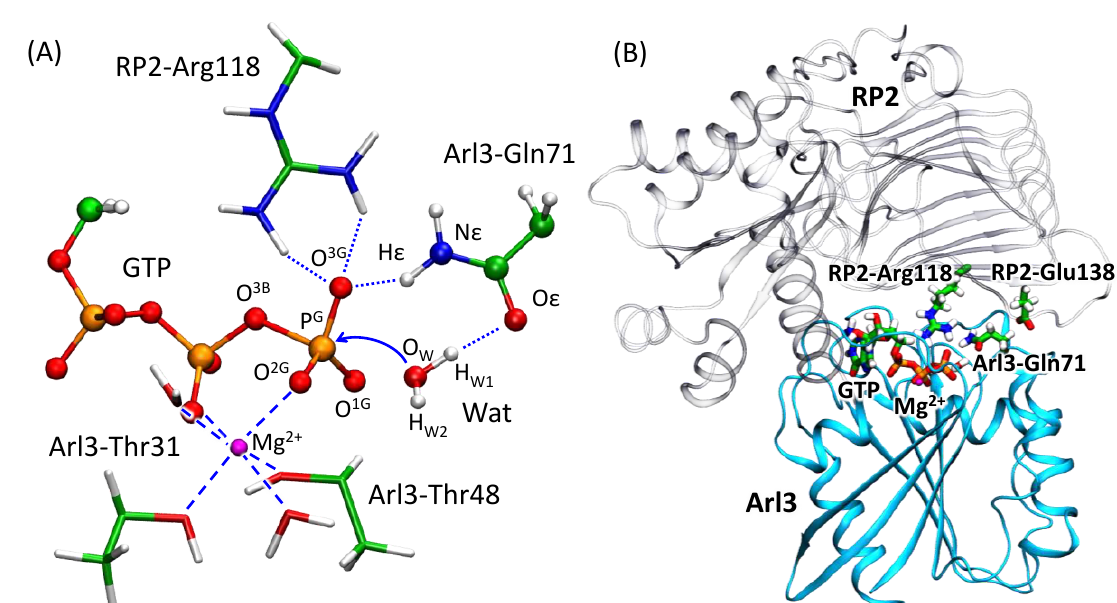
Figure 2. ( A ) Active site of the Arl3-RP2 complex in the ES conformation; ( B ) The Arl3-RP2 complex. Arl3 is shown in light blue cartoon representation and RP2 in transparent grey. Catalytically important residues, RP2-Arg118, RP2-Glu138 and Arl3-Gln71, GTP are shown in sticks. Here and in the following figures, blue dotted lines show hydrogen bonds and dashed lines—coordination bonds; atom color code: magnesium—magenta, oxygen—red, phosphorus—orange, nitrogen—blue, hydrogen—white and carbon—green.